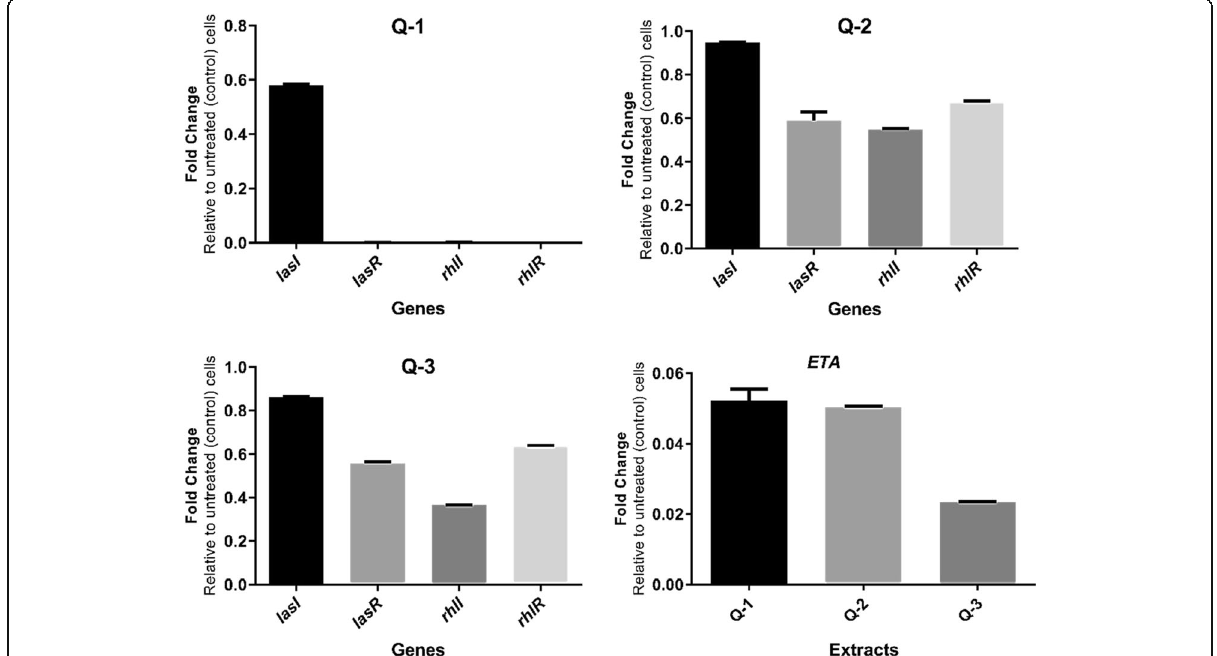
Fig. 4 Transcriptional profiles of quorum sensing and ETA genes expression of clinical isolates of P. aeruginosa when treated with SICs of Q. infectoria gall extracts. Transcriptional profiles were measured by RT-PCR. Q-1: ethyl acetate, Q-2: n-butanol, Q-3: ethanol extract, ETA : Exotoxin A. The aqueous extract blocked utterly the expression of QS and ETA gene (signal not